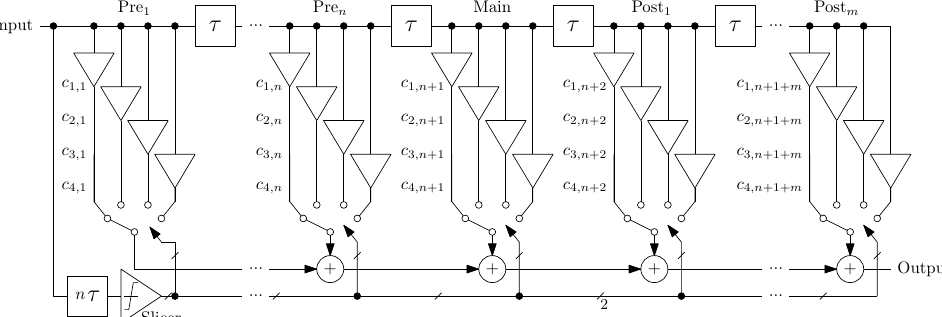
Figure 6. Block diagram of adaptive FFE, n pre and m post-taps, four sets of coefficients for PAM- 4